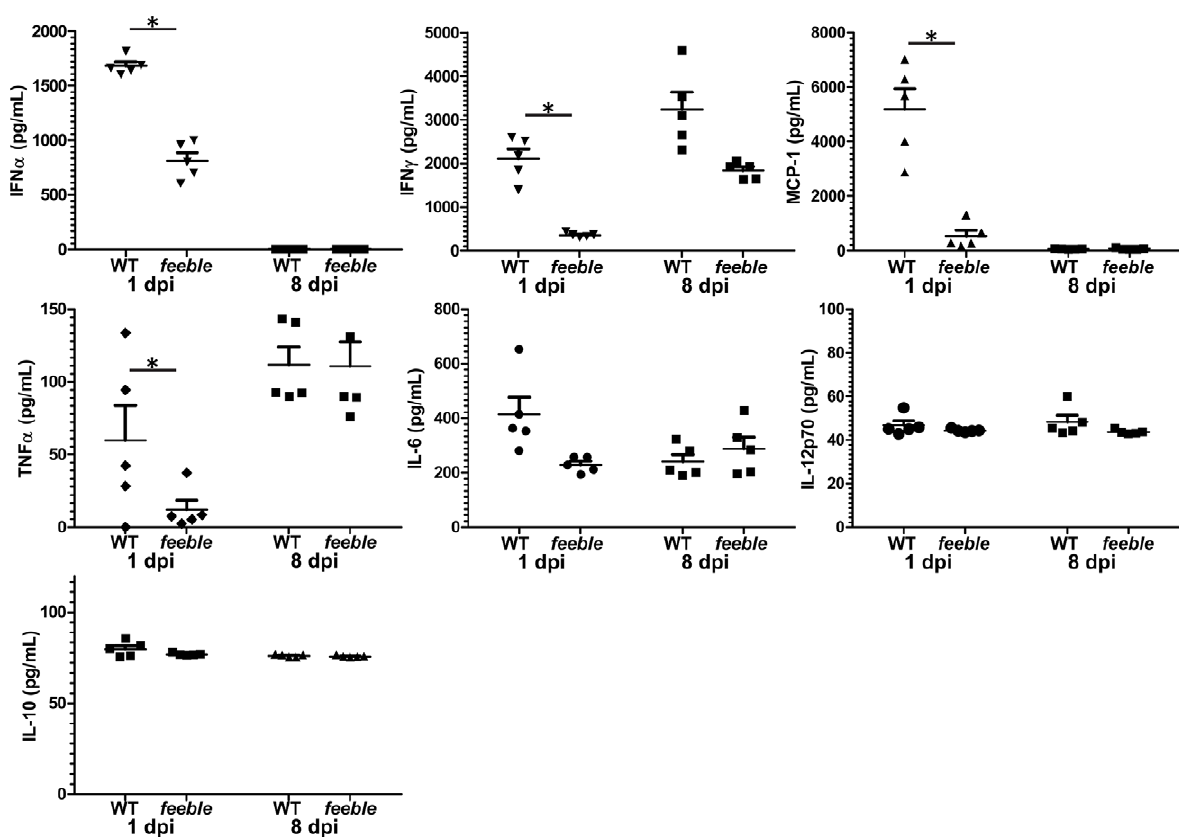
Figure 4. Slc15a4 is required for specific acute inflammatory cytokine production. One and 8 days post LCMV Cl13 infection serum was collected and the cytokines displayed were quantitated from WT and feeble mice. Individual replicates, mean and standard error of the mean are shown. Representative data of 2 independent experiments are shown; n=5 per group of infected mice. Unless marked, p . 0.05 between WT and feeble and not statistically significantly different.